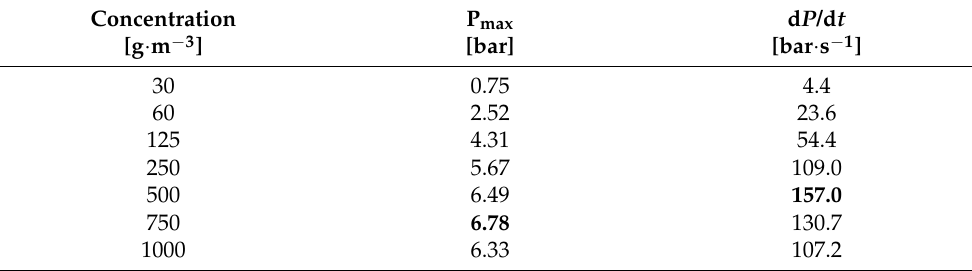
Figure 10. Pressure records for the LEL determination of PA12 polyamide sample. Table 3. Explosion parameters of PA12 polyamide sample.